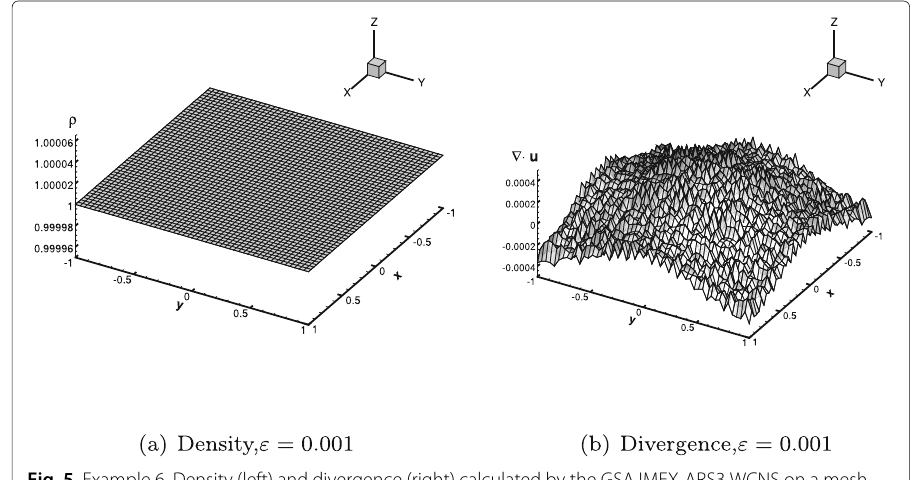
Fig. 5 Example 6. Density (left) and divergence (right) calculated by the GSA IMEX-ARS3 WCNS on a mesh 50 × 50 at t = 0.05. a Density, ε = 0.001. b Divergence, ε =